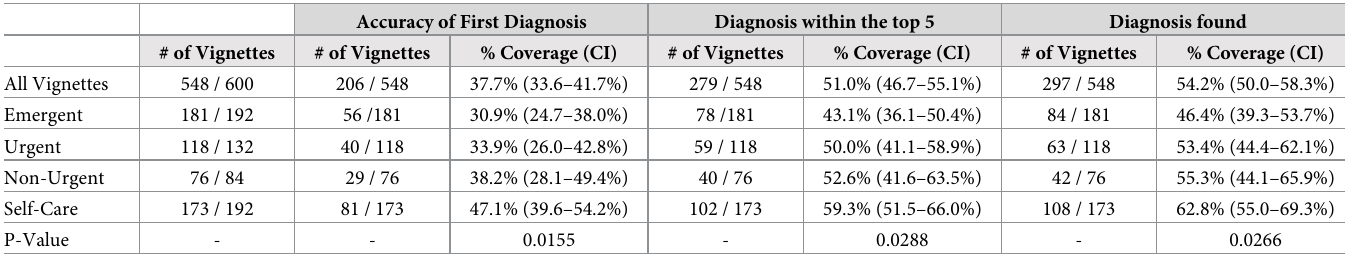
Table 2. Accuracy of diagnostic capability first, within the top five, within a list. Accuracy of First